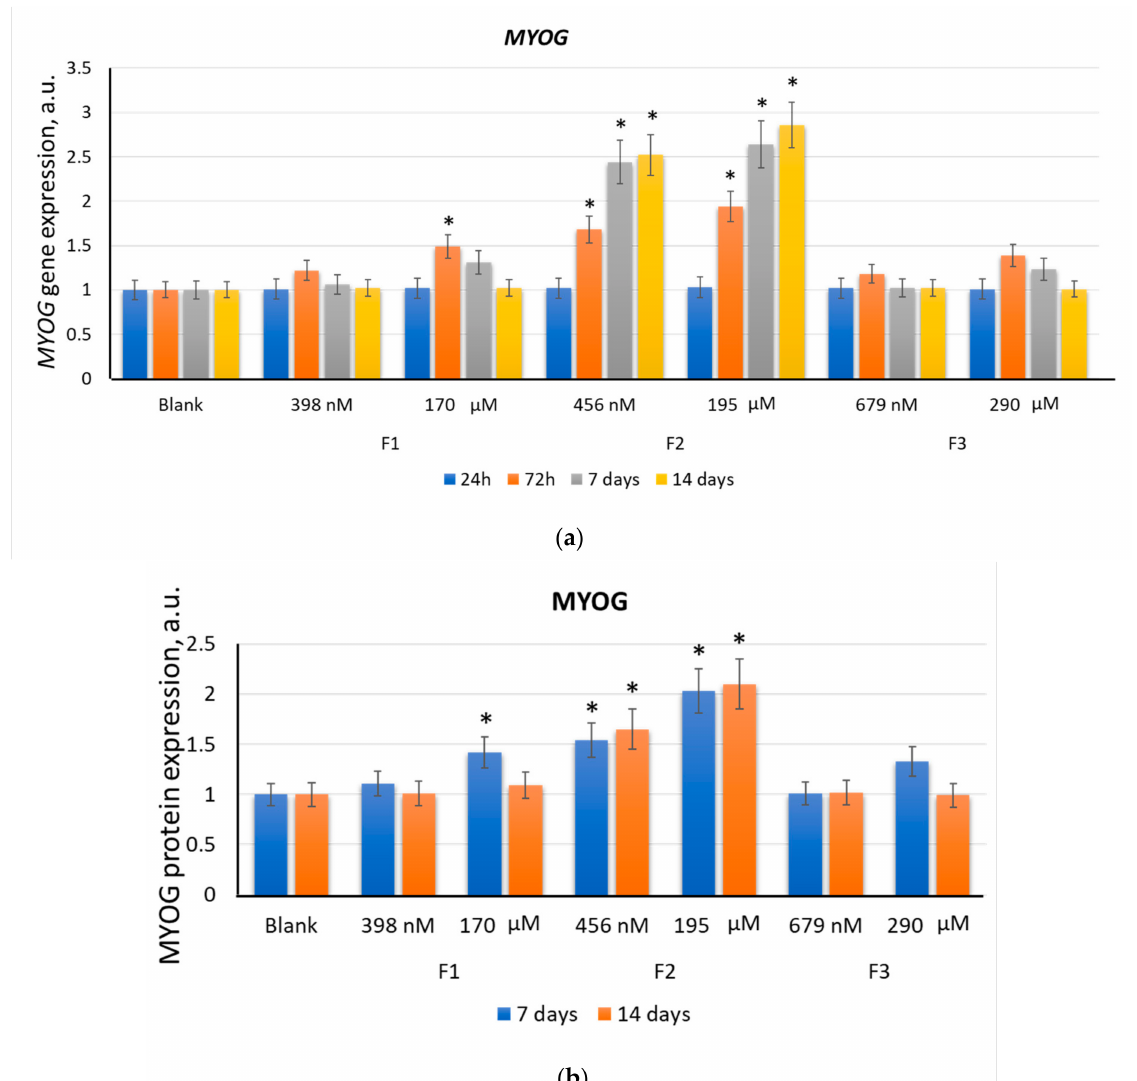
Figure 6. The effect of F1, F2, and F3 on the MYOG gene expression ( a ) and MYOG protein expression ( b ); the concentrations and exposition times are shown in the figure. The gene RNA amount was the mean value for three experiments related to the blank; the TBP gene was used as an internal reference gene; (*) denotes significant differences compared to blank cells, p < 0.005, in a Mann–Whitney test. In blank experiments, cells were incubated without the